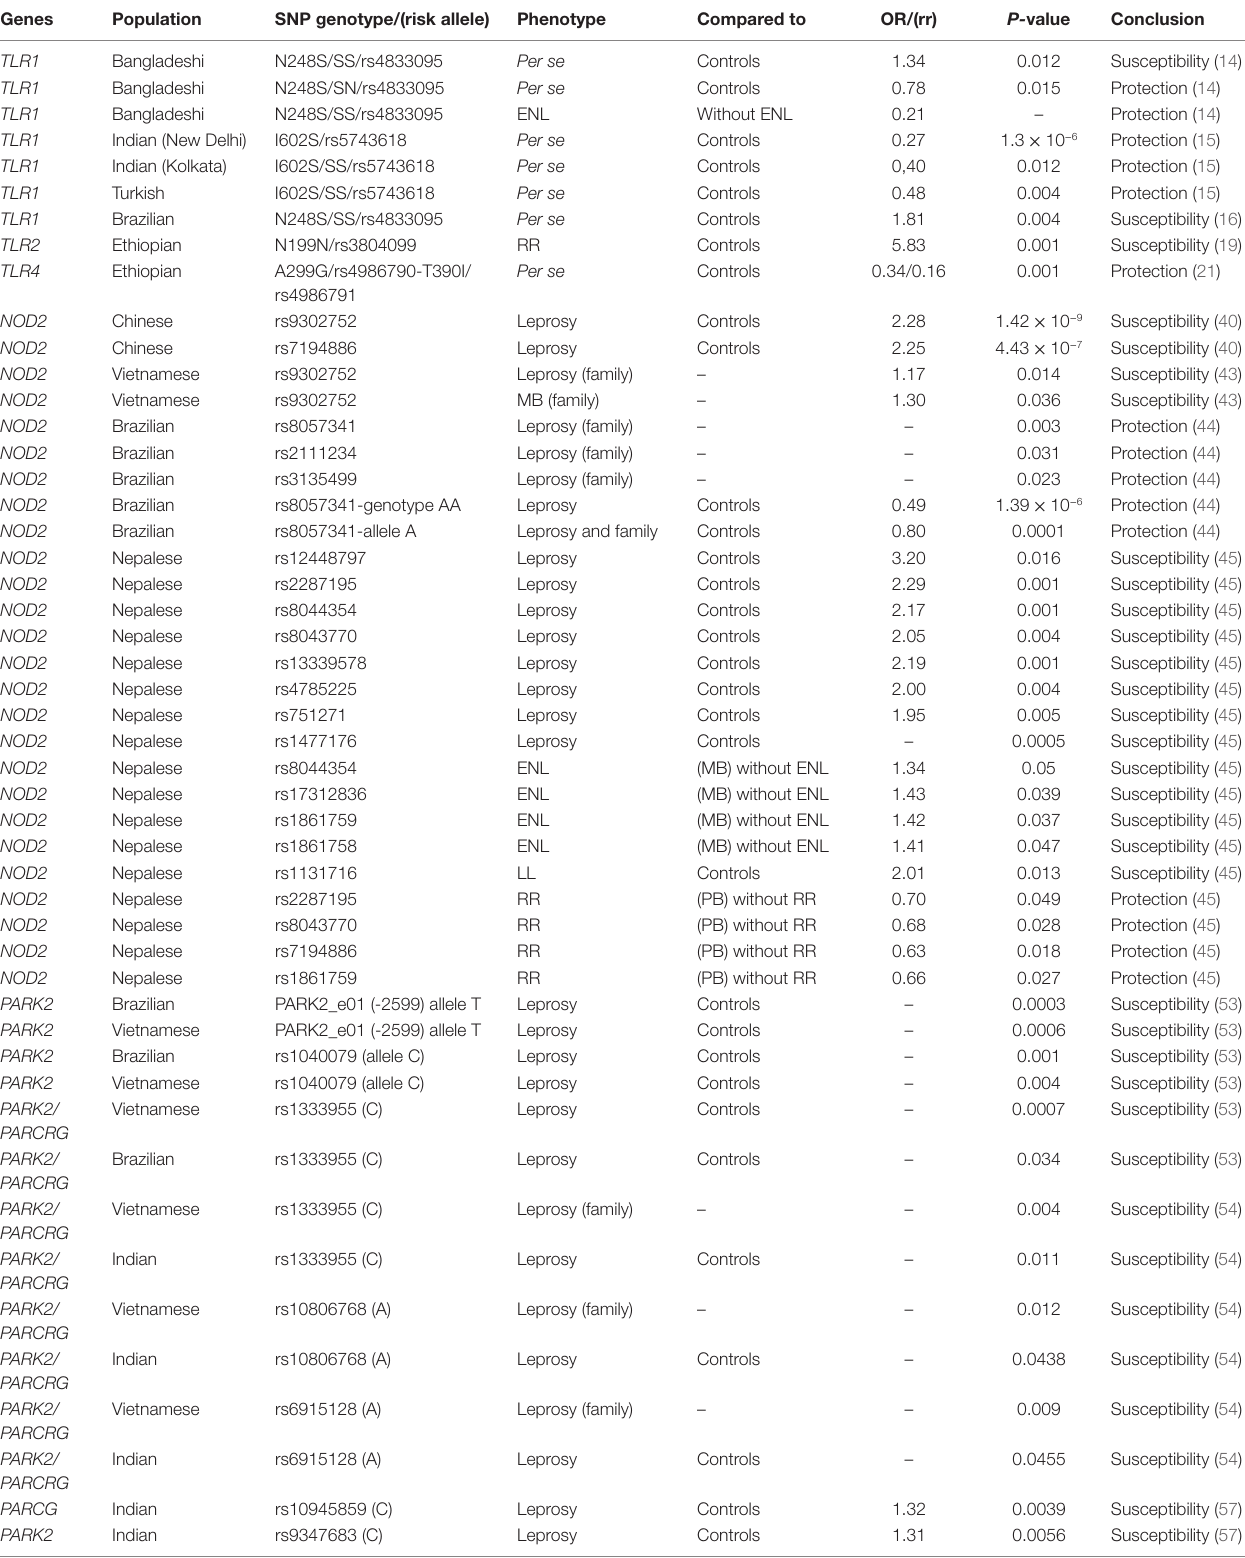
TABLe 1 | Summary of associations between genes of innate immune response TLR , NOD2 , PARK2 , PACRG , and